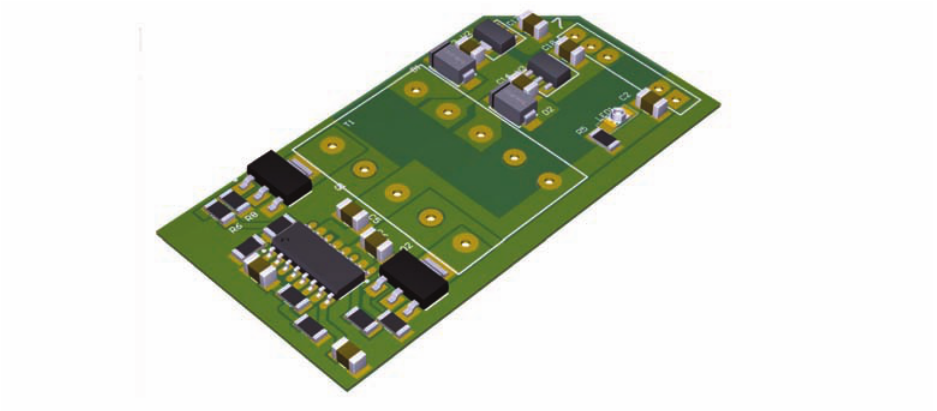
lectronic components. Fig. 17. Circuit diagram of the gate drive after mounting the el